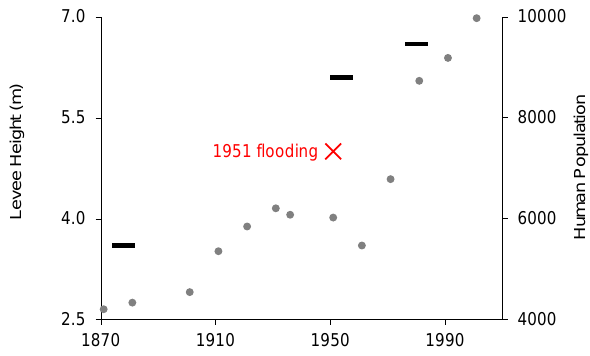
Fig. 6. Example of long-term dynamics of human-flood interac- tions: human population in Occhiobello (grey dots), surveyed height of the levee system (black rectangular dots), and high water level during the 1951 flooding (red